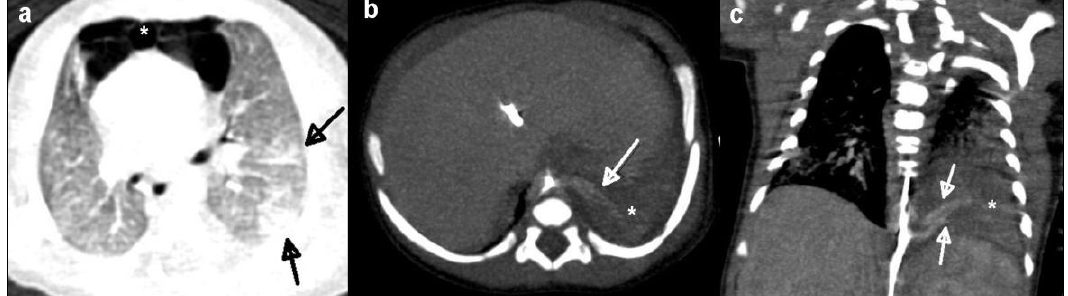
Figure 2: Contrast enhanced chest CT images of the newborn. (a) Axial plane CT in lung window reveals multiloculated, multiseptated, anterior mediastinal air collection between the pericardial sac and the thymus compatible with pneumomediastinum (asterix). Particularly, there are some ground glass opacities and reti- culonodular opacities indicating an infectious process in the inferior lobe of the left lung (black arrows). Axial plane reconstructed Chest CT in mediastinal window (b), demonstrates the anomalous mass like tissue which is the pulmonary sequestration located in the left lower lobe (asterix). It has a systemic arterial supply which is a branch of the aorta (white arrow). On coronal view (c), note the pulmonary sequestration (asterix) and other vascular structure parallel to the artery (white arrow) which is a draining vein to the azygos vein con- firmed by Doppler